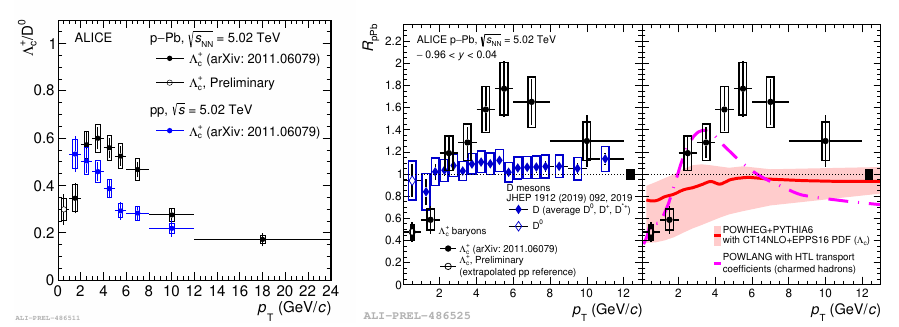
Figure 3. Left: The Λ + c / D 0 ratio as a function of p T measured in pp collisions and p–Pb collisions at 5.02 TeV [7]. Right: The nuclear modification factor R pPb of the Λ + collisions at √ s NN = 5 . 02 TeV, compared to R pPb of D mesons, as well as to model expectations [7].